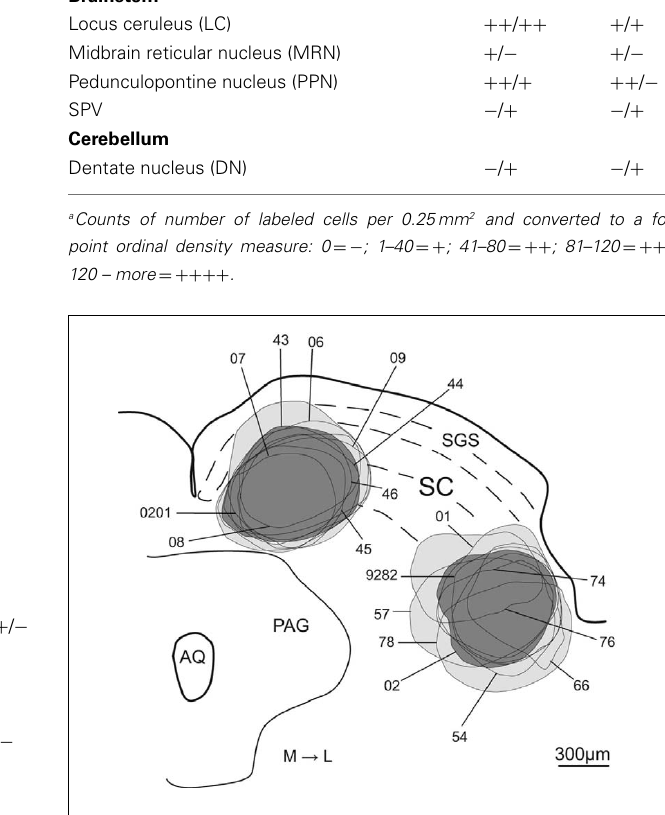
FIGURE 3 | Schematic representation of the FG injection sites into the medial and lateral sub-regions of SC. Lines indicate each injection site. Light gray represents the areas included in the population of all medial and lateral injection sites and dark gray shows the injection sites chosen as representative of the medial and lateral injection populations. Abbreviations: see